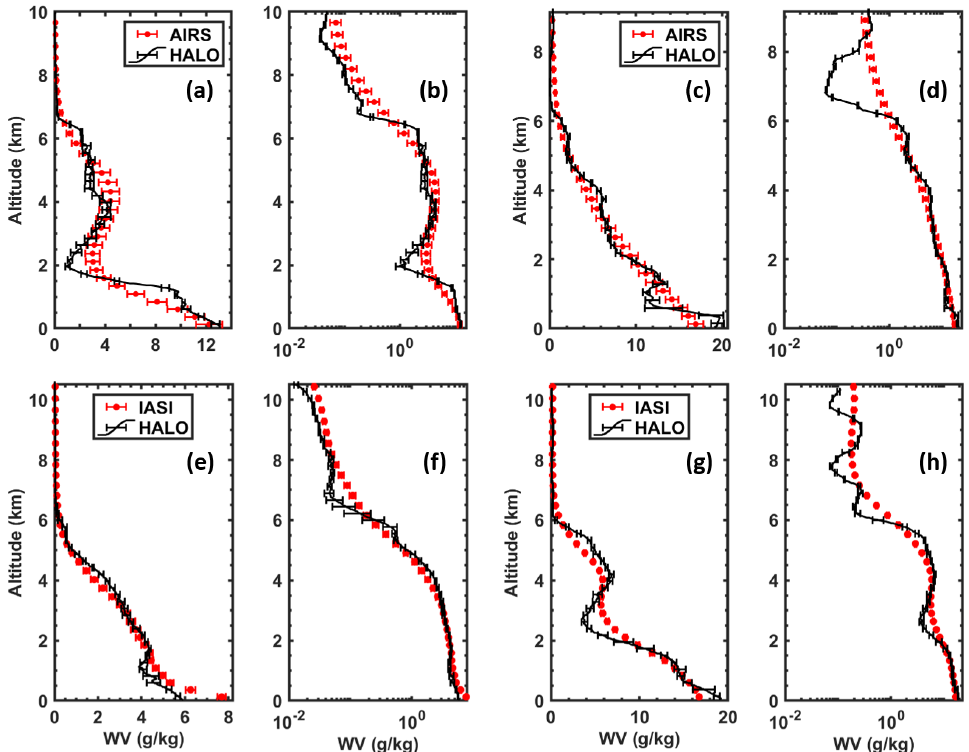
Figure 12. WV mixing ratio profiles from HALO versus (a–d) AIRS and (e–h) IASI with two locations each and both (a, c, e, g) linear and (b, d, f, h) log scales to emphasize capabilities across scales. The AIRS profiles are from 25 April 22:15UTC overpass, with the HALO profiles from (a, b) 22:36 and (c, d) 23:16UTC. IASI profiles are from (e, f) 23 April 04:00UTC overpass and 04:30UTC HALO profile and (g, h) 27 April 19:26UTC overpass and 19:12UTC HALO profile.